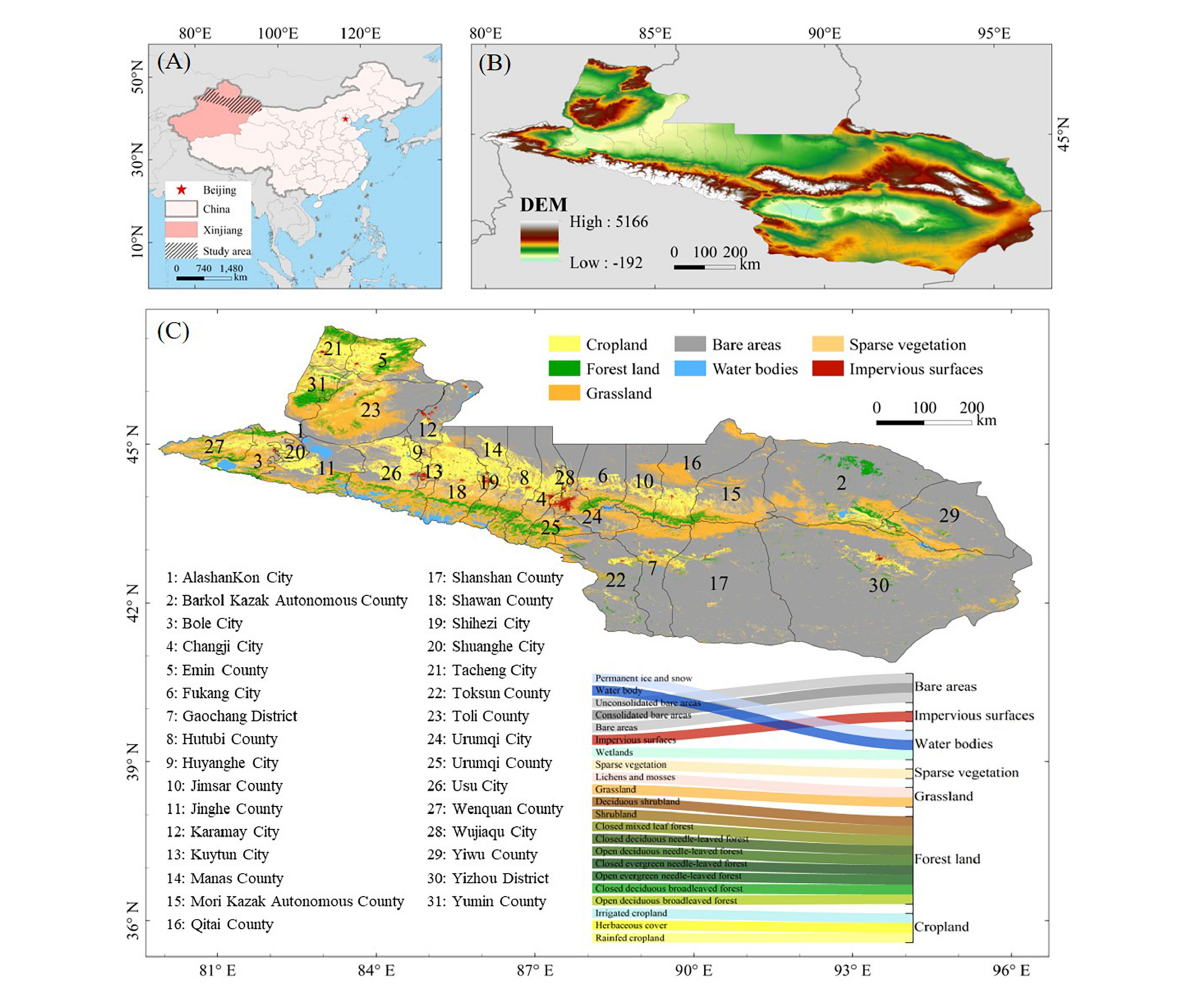
FIGURE1 (A) The location of the NSTM. (B) The elevation of the NSTM derived from the ASTER Global Digital Elevation Model at 30 m, and downloaded from the Geospatial Data Cloud of China. (C) The spatial patterns of land use of the NSTM in 2020 derived from GLC_FCS30. The corresponding relationships between the land use classification used in this study and the original system of the dataset are also